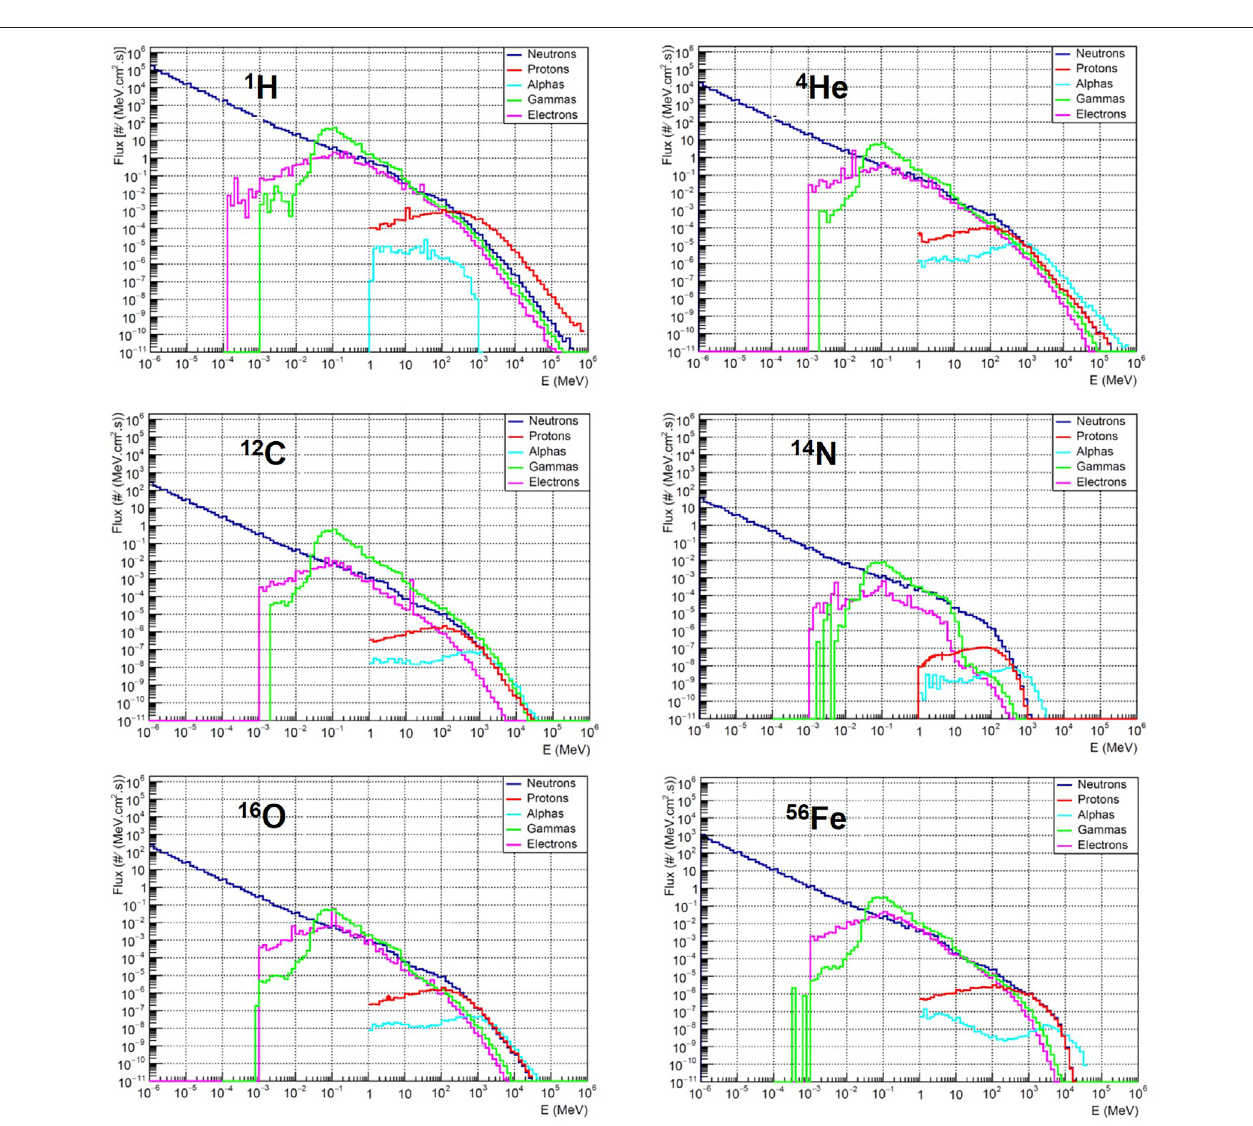
FIGURE 3 | Differential fl uxes for a selected set of particle species predicted with dMEREM resulting from the different considered GCR sources — Protons, 4 He, 12 C, 14 N, 16 O, and 56 Fe nuclei — with the ISO-15390 model for the conditions corresponding to early September 2017 at the Gale Crater.